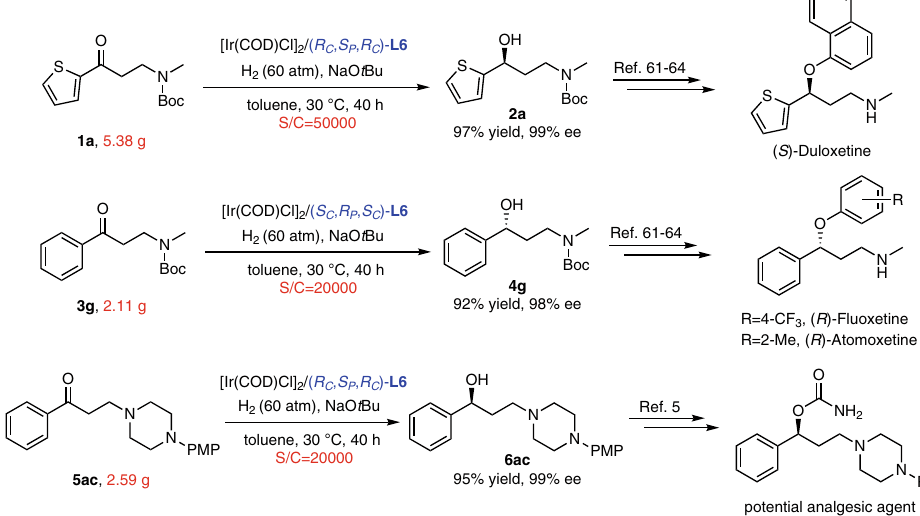
Fig. 5 Gram-scale reactions. The asymmetric hydrogenation of 1a , 3g , and 5ac with high